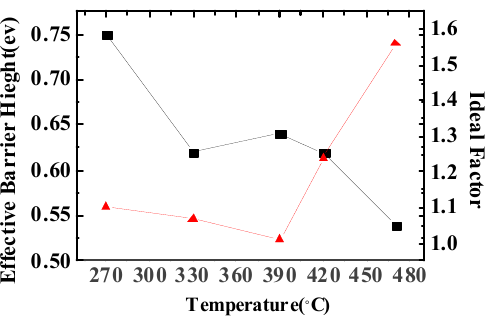
Figure 5. SBH and ideality factor of NiSiGe/n ‐ Si Schottky contact with different MWA temperatures.